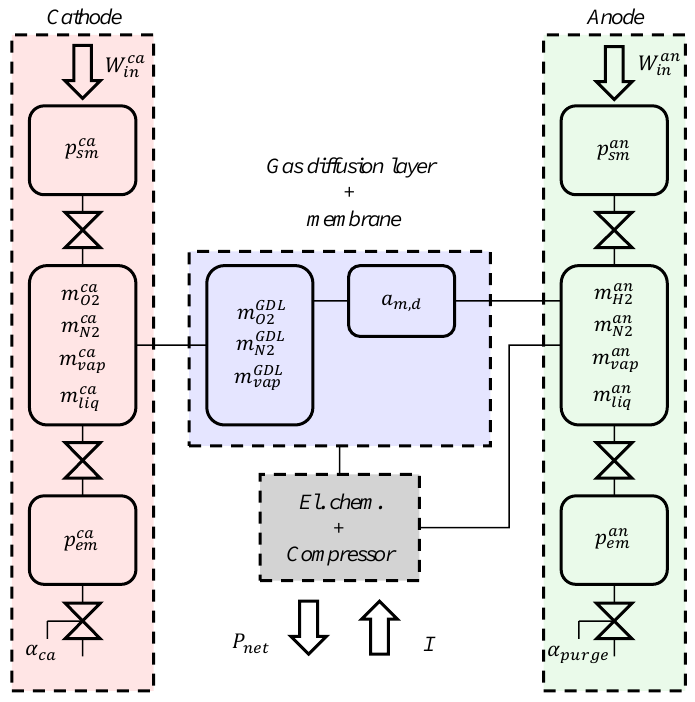
Figure 4. Fuel cell model structure used in the paper. Different colors denote different